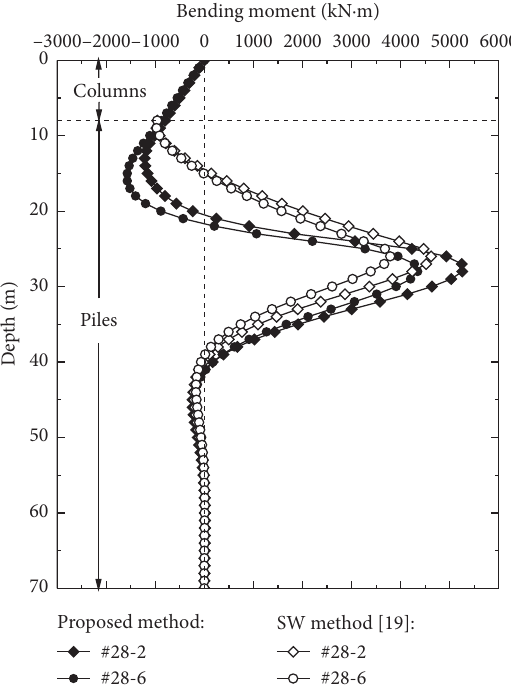
Figure 10: Computed bending moment of columns and piles.